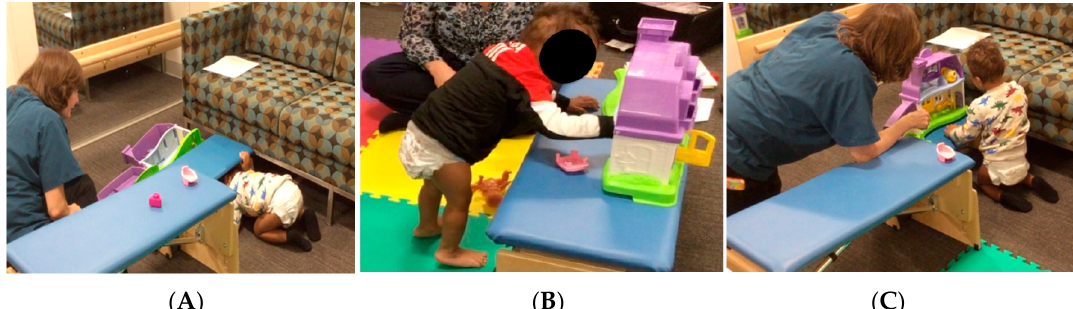
Figure 2. Sitting Together And Reaching To Play (START-Play) Intervention. When S played with a toy house, he needed to problem solve the best solution for play with the smaller toy house pieces. He could decide if ( A ) he wanted to transition from an upright posture to a lower one to look under the bench for hand-held toys, ( B ) he wanted to cruise around the bench to access a different affordance of the toy, or ( C ) he wanted to make a postural adjustment, such as transitioning from heel sitting to tall kneeling, to better visually engage with the toy house to manipulate and role play a story with the smaller toy pieces (affordance). S chose the toy house to play with which provided a variety of combined motor and problem-solving opportunities. He self-selected the best motor solution for the play task with his parent or therapist simultaneously supporting the “just right” level of challenge via environment and task modifications.